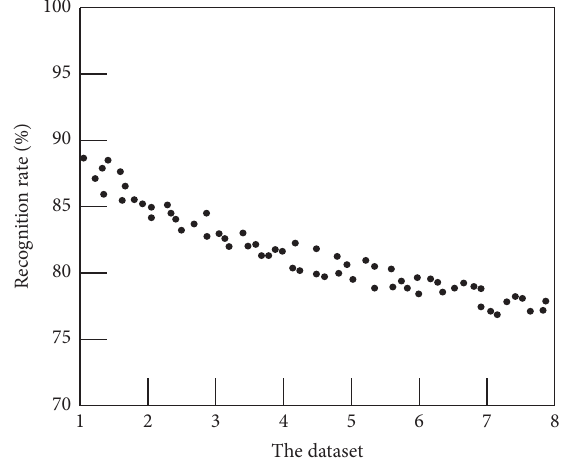
Figure 4: Changes in the recognition rate of Method 2.